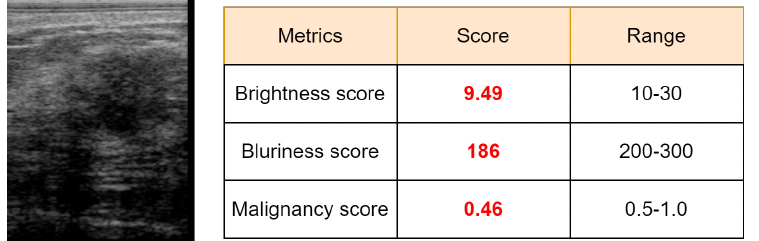
Figure 12. Malignant sample misclassified by our